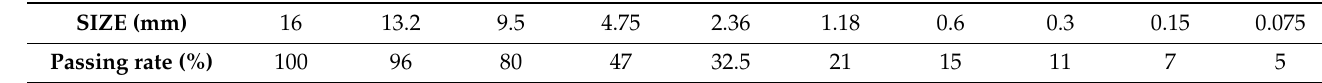
Table 1. Aggregate